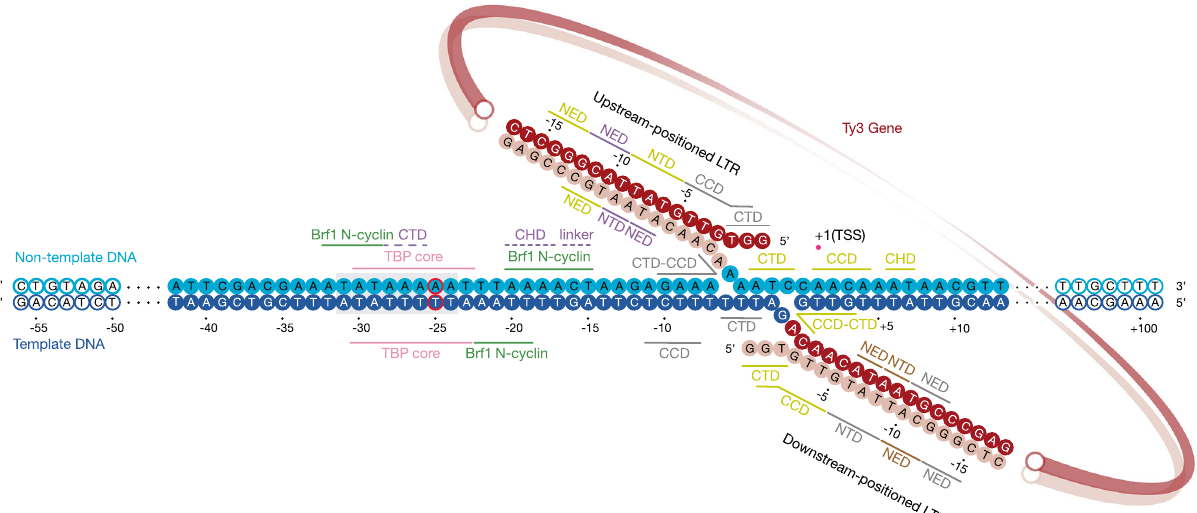
Fig. 3 Details of protein – DNA interactions and integration site location on RNA Pol III-transcribed genes. DNA nucleotides of the tD(GUC)K gene modelled in the Ty3 strand-transfer complex are depicted as solid circles and numbered relative to the TSS. Template and non-template strands of the tDNA are shown in dark and light blue, respectively. Mutation of nucleotide − 25 to break the pseudo-symmetry of the TATA-box is outlined in red. The TATA-box is highlighted with a grey box. Ty3 long-terminal repeats (LTRs) are highlighted in red shades. Protein – DNA and protein – protein interactions are indicated with solid and dashed lines,